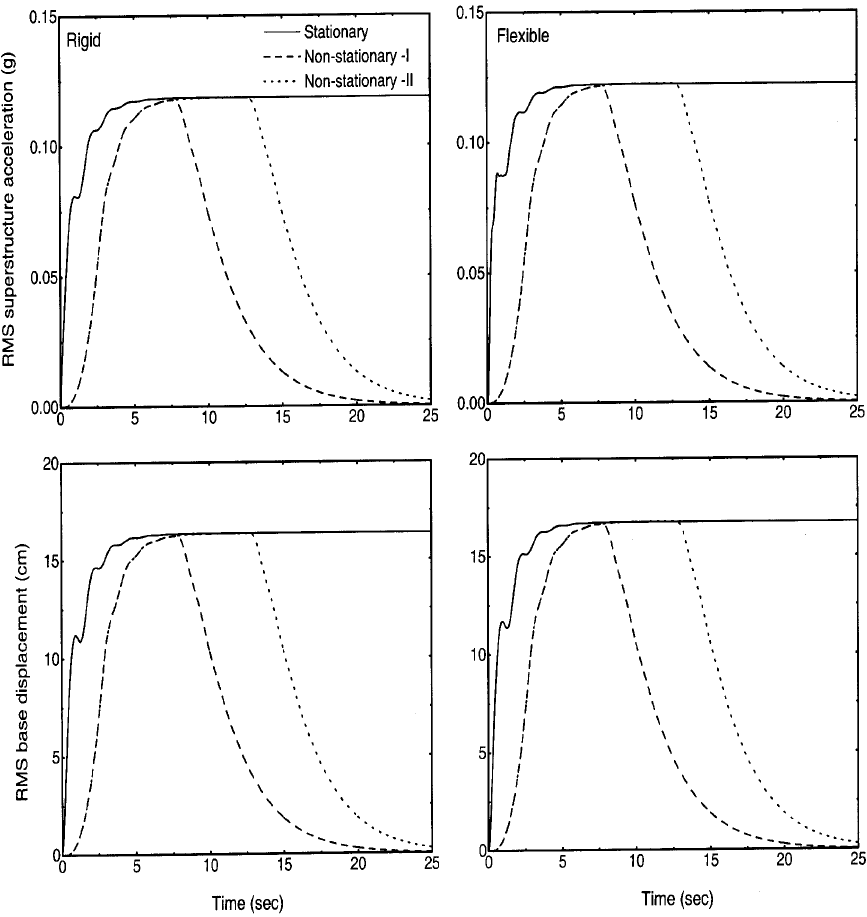
Fig. 6. Time variation of the RMS superstructure acceleration and base displacement of the structure isolated by the FPS system ( T s = 0 . 5 sec, T = 2 . 5 sec and µ = 0 . 05 b